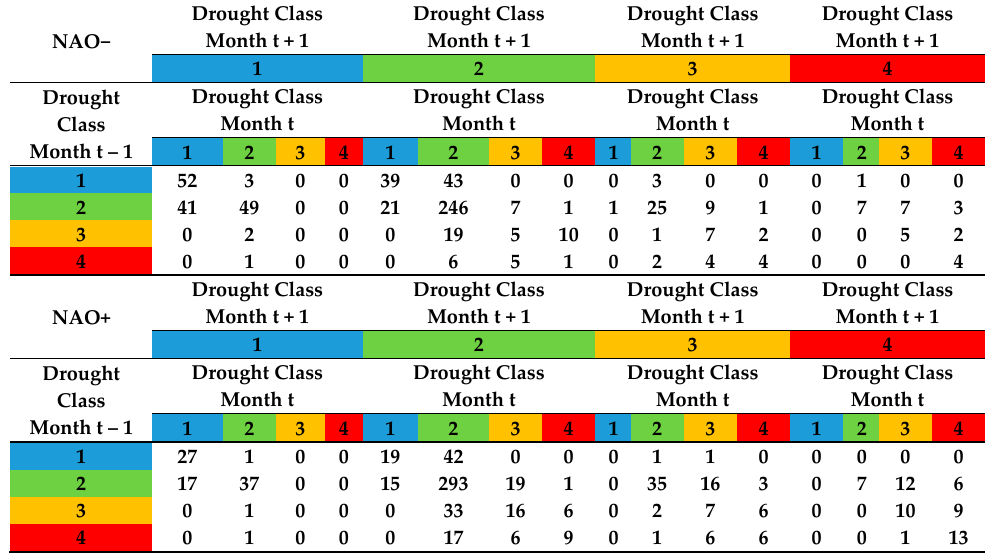
Table 4. Counts of two consecutive transitions between drought classes of SPEI6 (t − 1 → t → t + 1) for NAO − and NAO+.